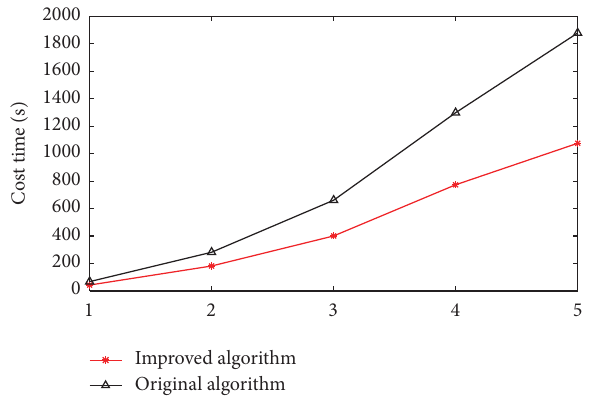
Figure 1: Comparison of the SPRINT algorithm and the improved SPRINT